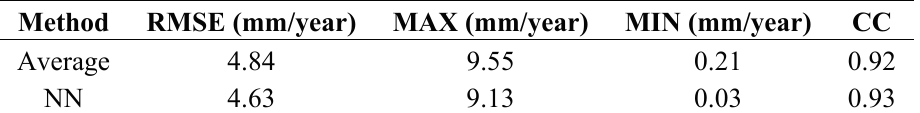
Table 1. Comparison of average subsidence rate between TSX PS results and leveling measurements.